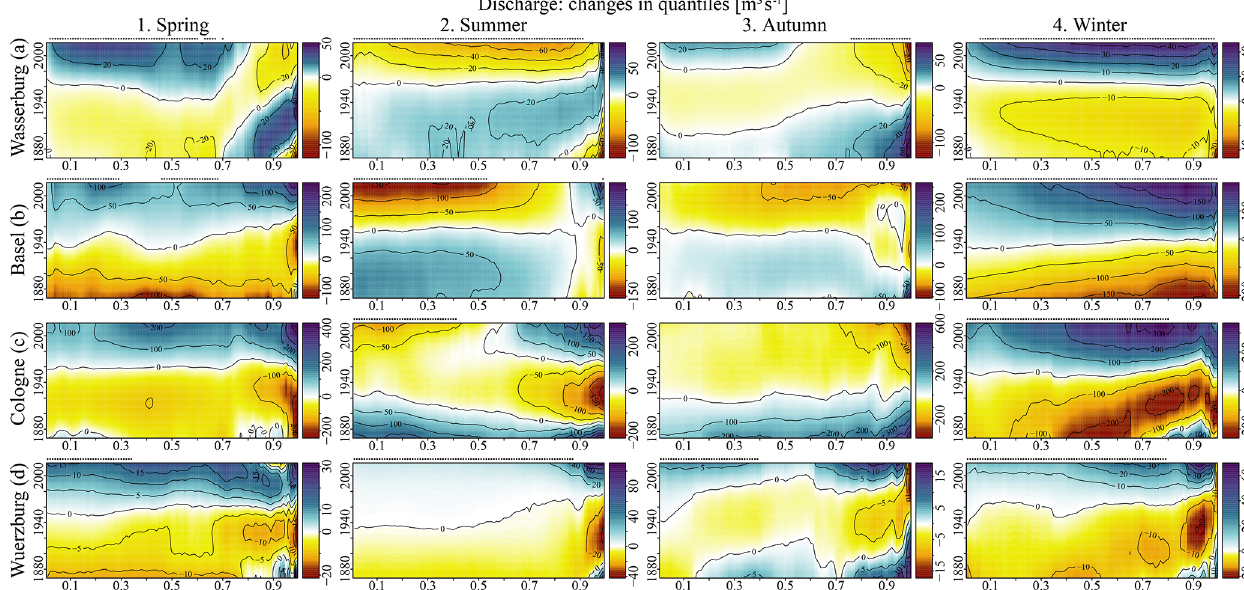
Figure B1. Changes in quantiles for individual seasons (spring: March–May, summer: June–August, autumn: September–November and winter: December–February) for discharge measured at gauges Wasserburg (a) , Basel (b) , Cologne (c) and Würzburg (d) . Points on top of the panels indicate days/probabilities with significant changes according to the Mann–Kendall trend test. Time frame investigated: 1869– 2016.